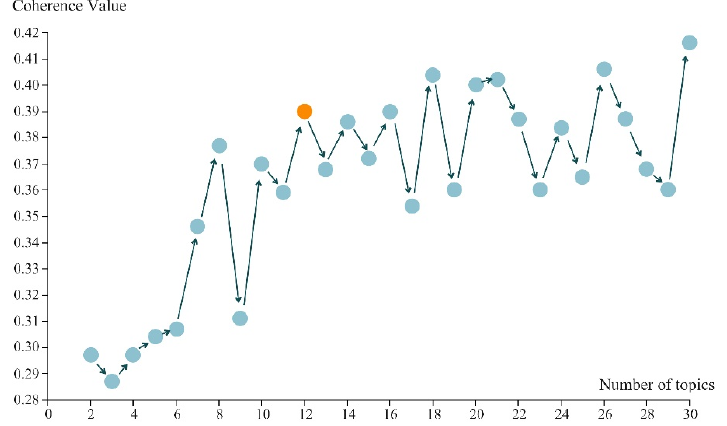
Figure 4. Coherence values of models with a different number of topics (the orange dot indicates the selected number of topics). Table 4. Topic model with 12 selected topics.